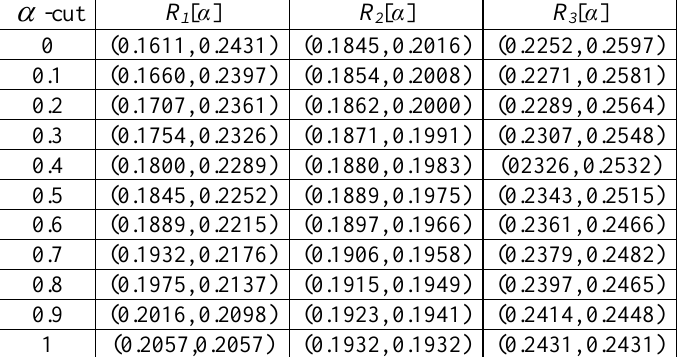
Table 1.  -cut of the hesitant fuzzy membership function of the reliability system